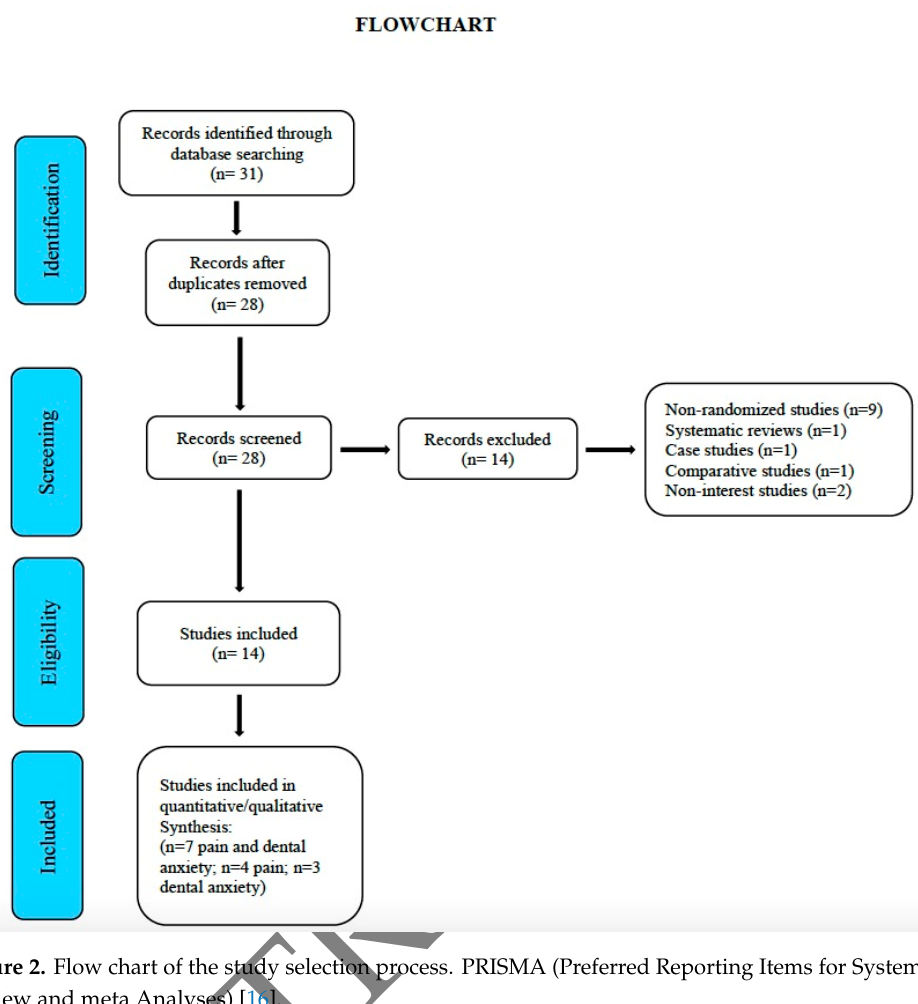
Figure 2. Flow chart of the study selection process. PRISMA (Preferred Reporting Items for Systematic Review and meta Analyses) [16].